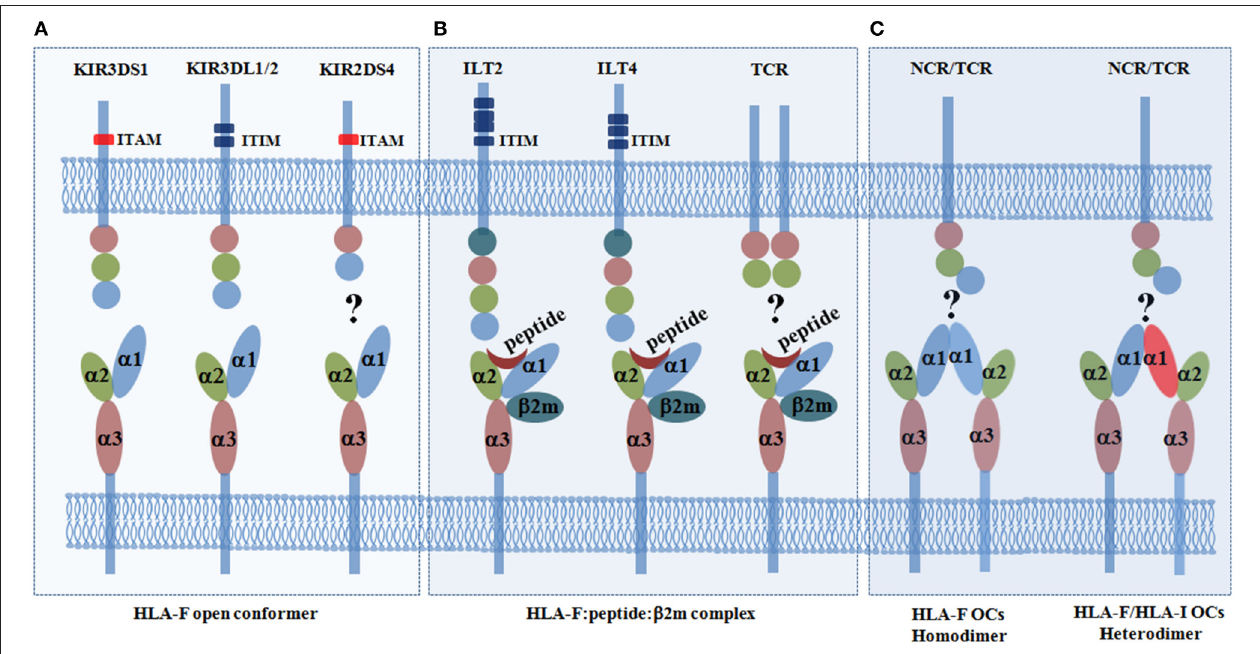
FIGURE 1 | Immune receptors for the human leukocyte antigen (HLA-F) open conformer (OC) and HLA-F:peptide: β 2 m complex. (A) HLA-F OCs can be recognized with the highest affinity by the activating receptor KIR3DS1 and can be recognized by the inhibitory receptors KIR3DL1/2. However, the results regarding the interaction of the HLA-F OC and the activating receptor KIR2DS4 are disputed ( 27, 28, 30, 31). (B) The HLA-F:peptide: β 2 m complex can only be recognized by the inhibitory receptors immunoglobulin (Ig)-like transcript receptor 2 (ILT2) and ILT4 (29, 30). However, whether there are HLA-F peptide-restricted T cell receptors (TCRs) is not yet known (30). (C) HLA-I OCs can be expressed on the cell surface as homodimers (43), and it has been postulated that HLA-I/HLA-F heterodimers can form (44). Whether HLA-F can be recognized by other TCRs or natural killer cell receptors (NCRs) remains to be explored. Killer cell immunoglobulin-like receptors (KIRs) are transmembrane glycoproteins expressed on natural killer (NK) cells and on subpopulations of T cells. KIRs have either two (2D) or three (3D) extracellular immunoglobulin (Ig)-like domains and different cytoplasmic tails (short or long). Inhibitory KIRs have long cytoplasmic tails (L) that contain immunoreceptor tyrosine-based inhibition motifs (ITIMs). Activating KIRs have short cytoplasmic tails (S) that lack ITIMs but associate with the immunoreceptor tyrosine-based activation motif (ITAM), such as the adapter DAP12, via a positively charged arginine or lysine residue in their transmembrane domain. Immunoglobulin-like transcript 2 (ILT2, also known as CD85j and LIR1) has four extracellular Ig-like domains and four cytoplasmic ITIMs. ILT4 (also known as CD85d and LIR2) has four extracellular Ig-like domains and three cytoplasmic ITIMs. TCRs (T cell receptors) recognize peptides presented by HLA